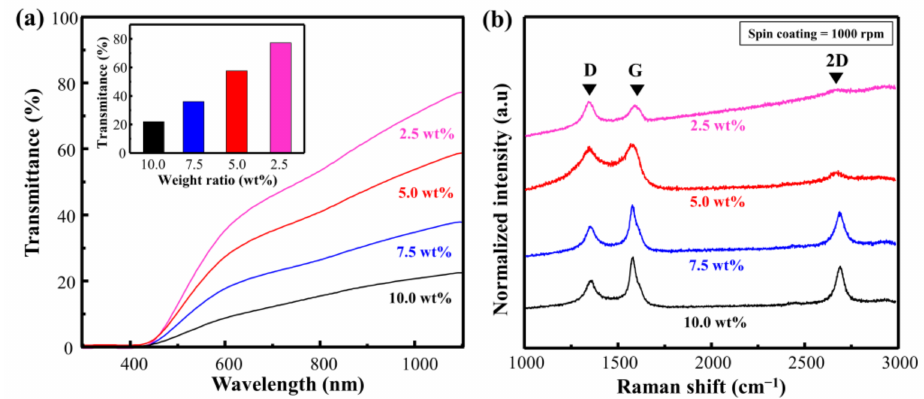
Figure 3. ( a ) Vis–NIR spectra of spin-coated Cu@PI film and ( b ) Raman spectra of Cu@LSC with different condition of weight ratios of Cu to